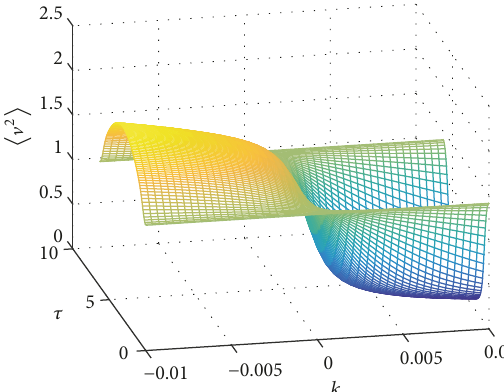
Figure 9: The dependence of the mean square electric voltage ⟨ V 2 ⟩ on 𝜏 and 𝑘